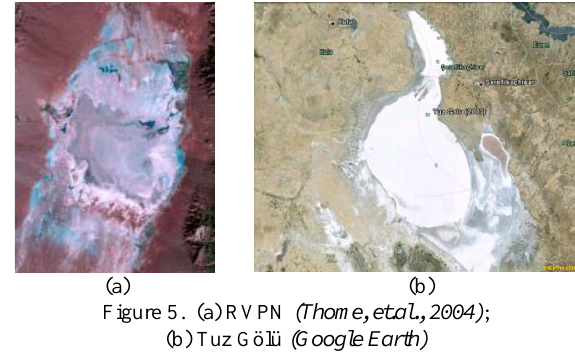
Figure 5. (a) RVPN (Thome, et.al., 2004) ; (b) Tuz Gölü (Google